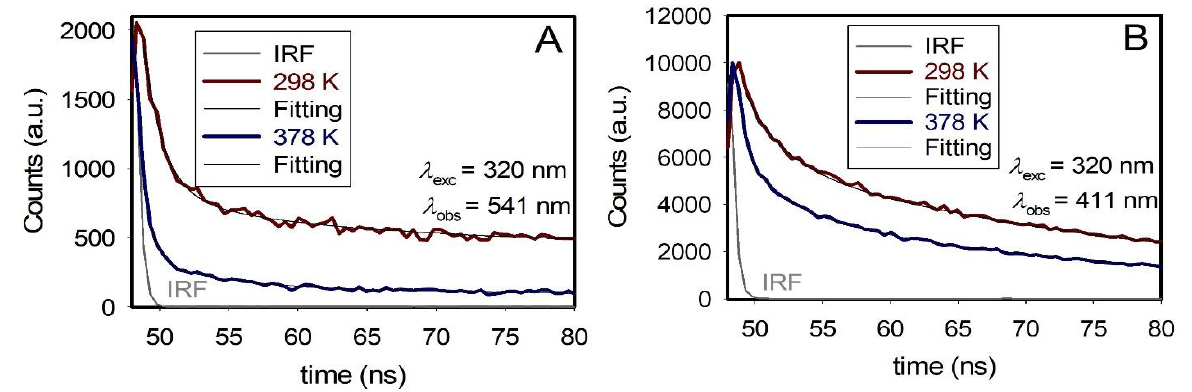
Figure 4. PL decays upon excitation at 320 nm monitored at the yellow band ( A ) and UV band ( B ) of ZnO–SiO 2 solids as a function of temperatures in kelvin (K). The exact monitoring wavelengths are indicated directly on the graph.